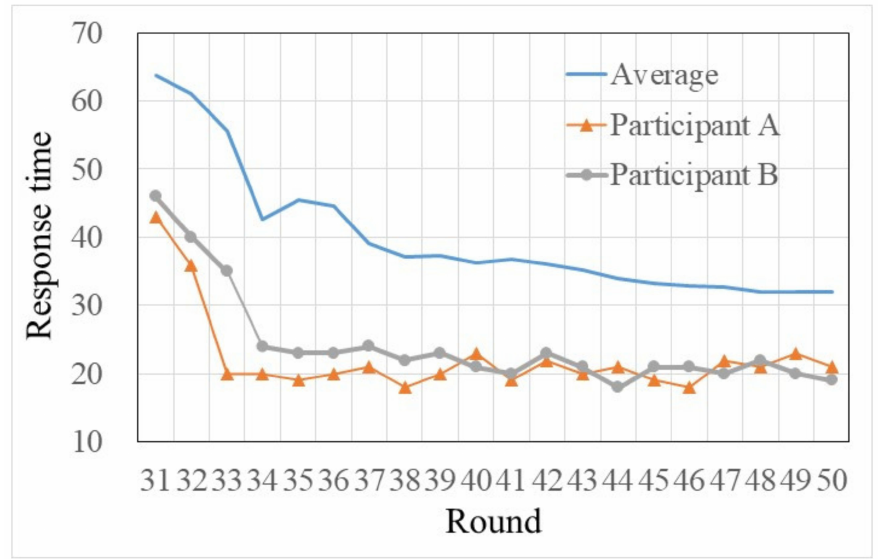
Figure 9. The response time of two strong participants in rounds 31–50.